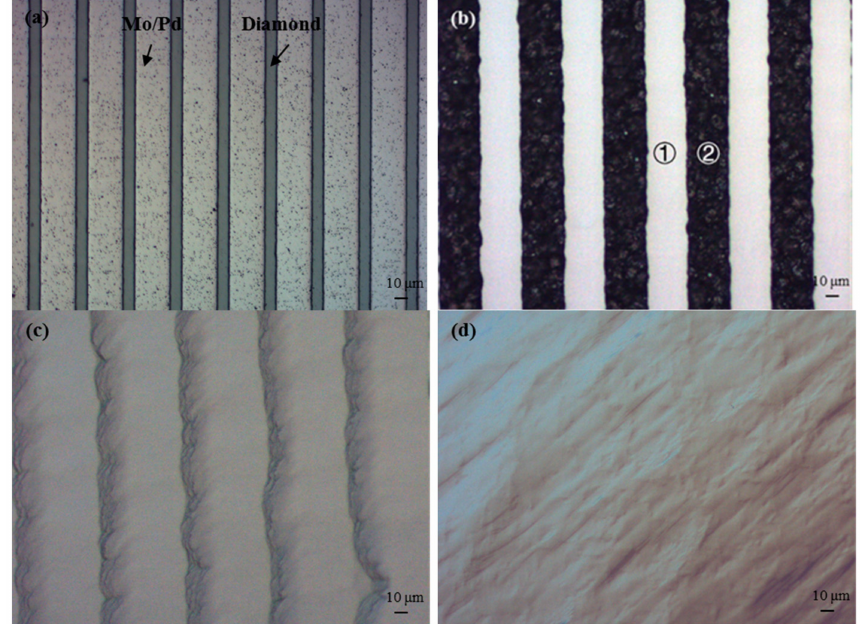
Figure 2. Optical images during the first ELO step. Panel ( a ) shows an image of the sample before MPCVD growth. Panels ( b – d ) show optical images of the sample after microwave plasma-enhanced chemical vapor deposition (MPCVD) growth for 40, 80 and 240 min, respectively. In Panel ( b ), Area 1 (cid:13) and Area 2 (cid:13) were originally diamond windows and Mo/Pd layers in the grooves,